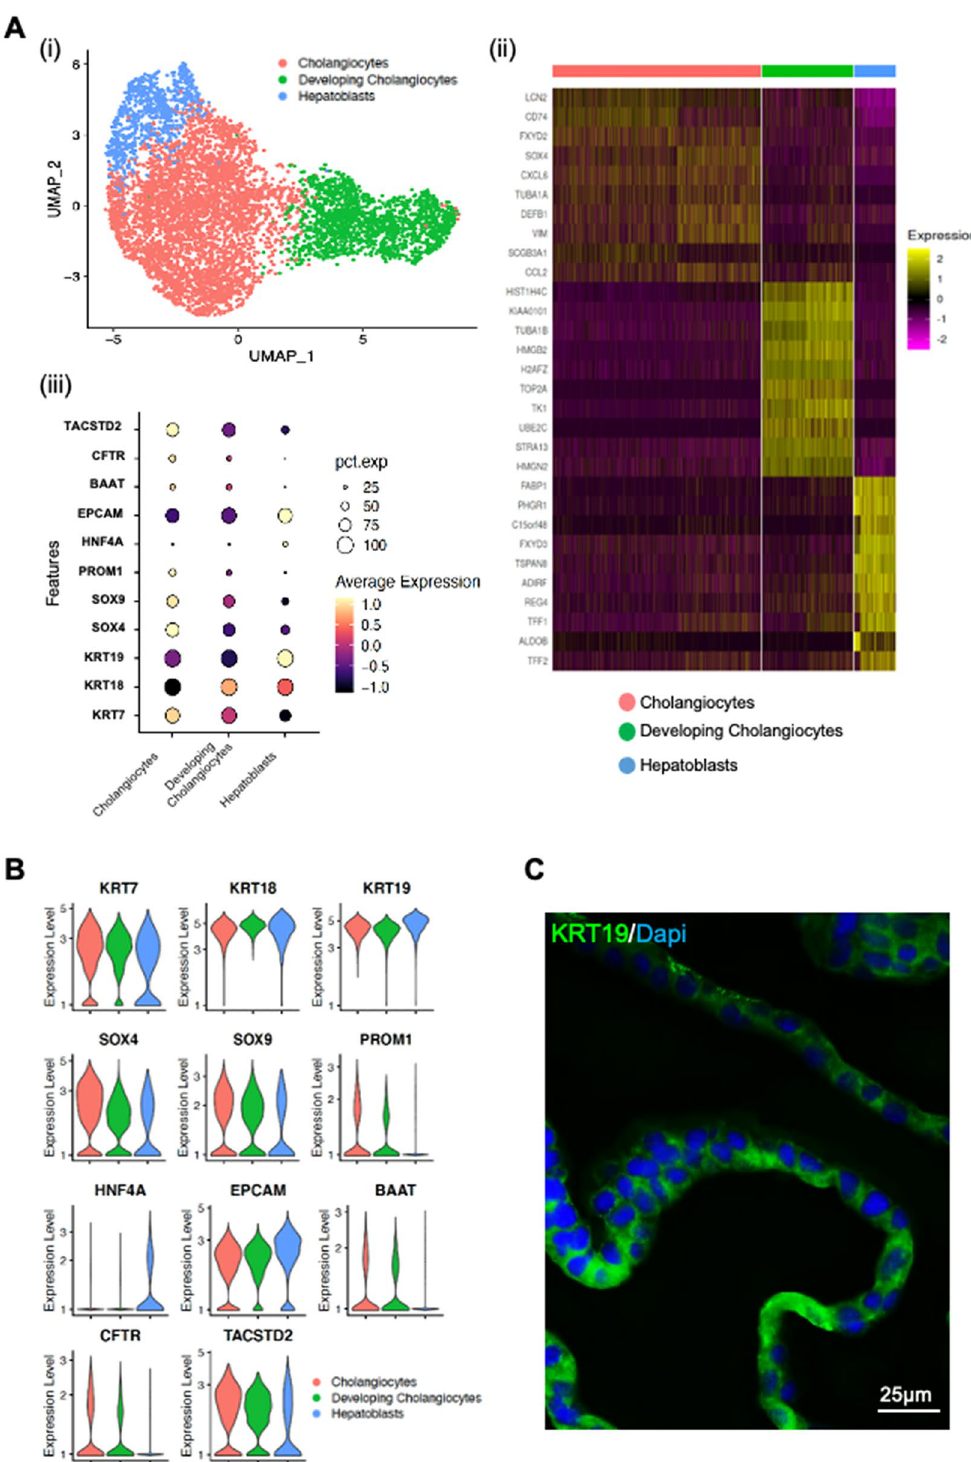
Figure 1. Human liver organoid cells expressed markers of cholangiocyte and hepatoblast. Characterisation of human liver organoids. ( A (i)) UMAP showing the assigned identity for each cluster (3 clusters) in 10X Genomics single-cell RNA sequencing analysis of human control liver organoids. ( A (ii)) Heatmap of top 10 markers expressed for each clusters in HB control organoids at p < 0.05. ( A (iii)) Dot plot showing expression of canonical markers used for identification of clusters including cytokeratin-19 (KRT19) and epithelial cellular adhesion molecule (EPCAM). ( B ) Violin plots showing levels of expression of canonical markers for cholangiocytes and hepatoblast used for classification of cell types in control liver organoids. ( C ) Immunofluorescence staining for KRT19 of human control liver